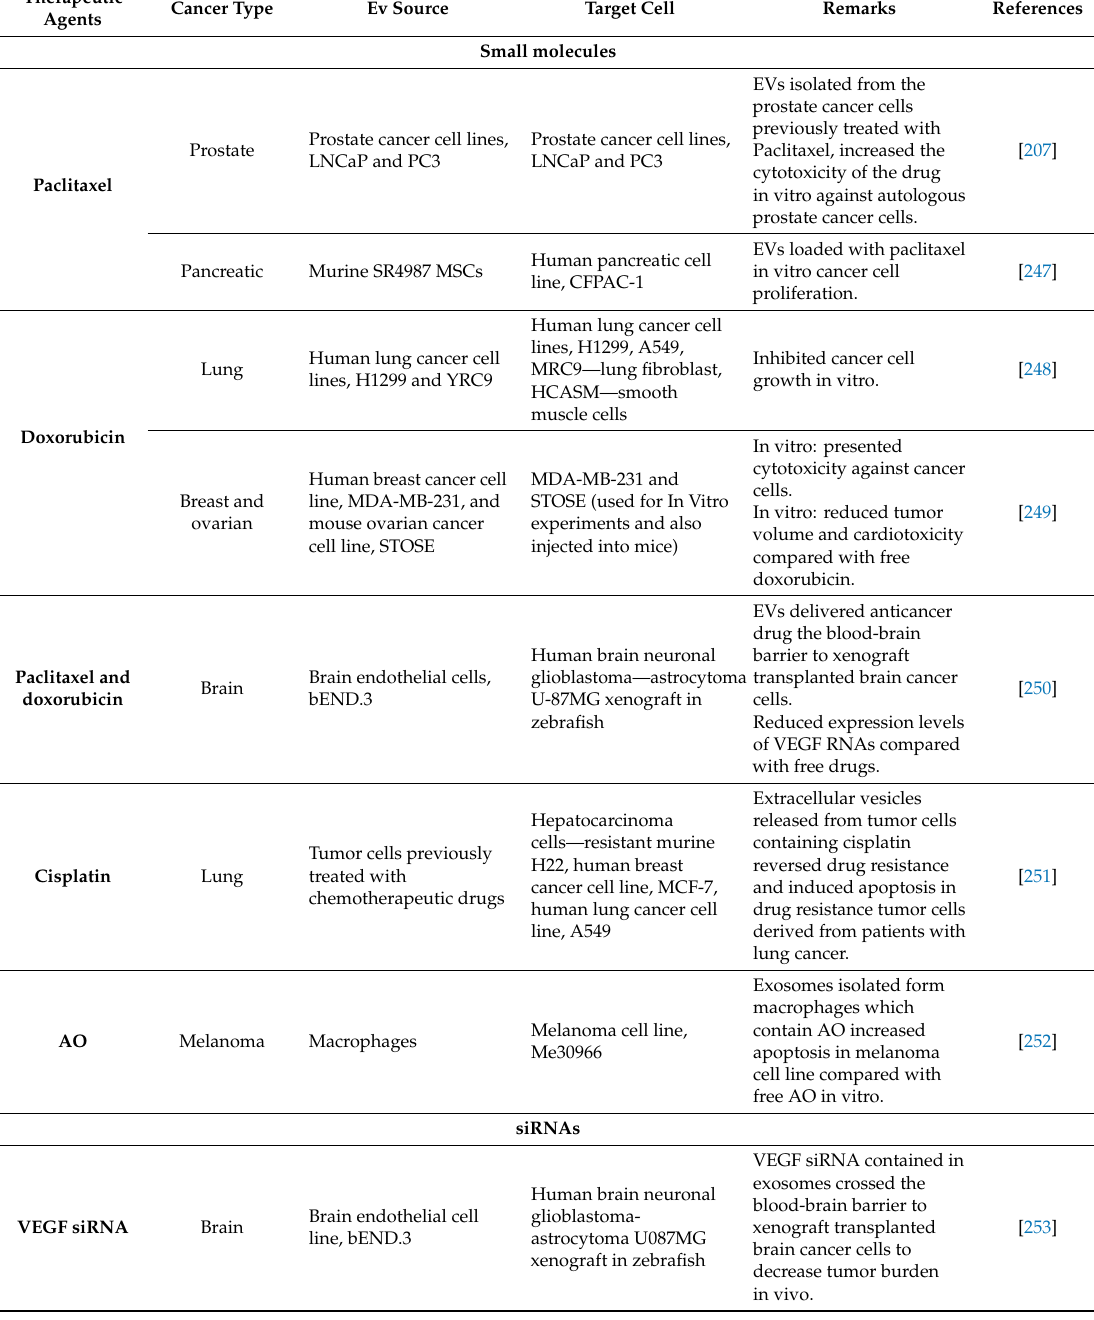
Table 3. EVs as drug delivery agents for cancer